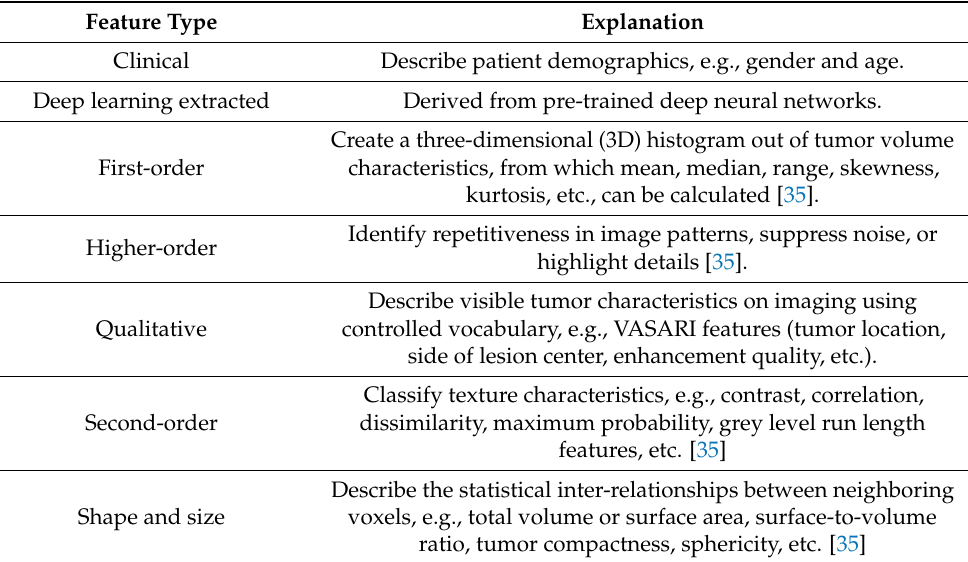
Table 1. Overview of commonly extracted feature types in studies developing ML prediction